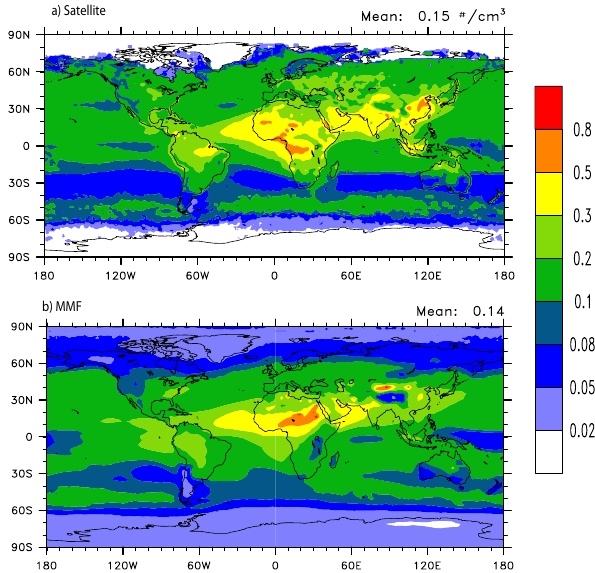
Fig. 23. Global annual-averaged AOD in the MMF model (a) , and Figure 23 a satellite AOD retrieval composite (Kinne et al., 2006) (b)